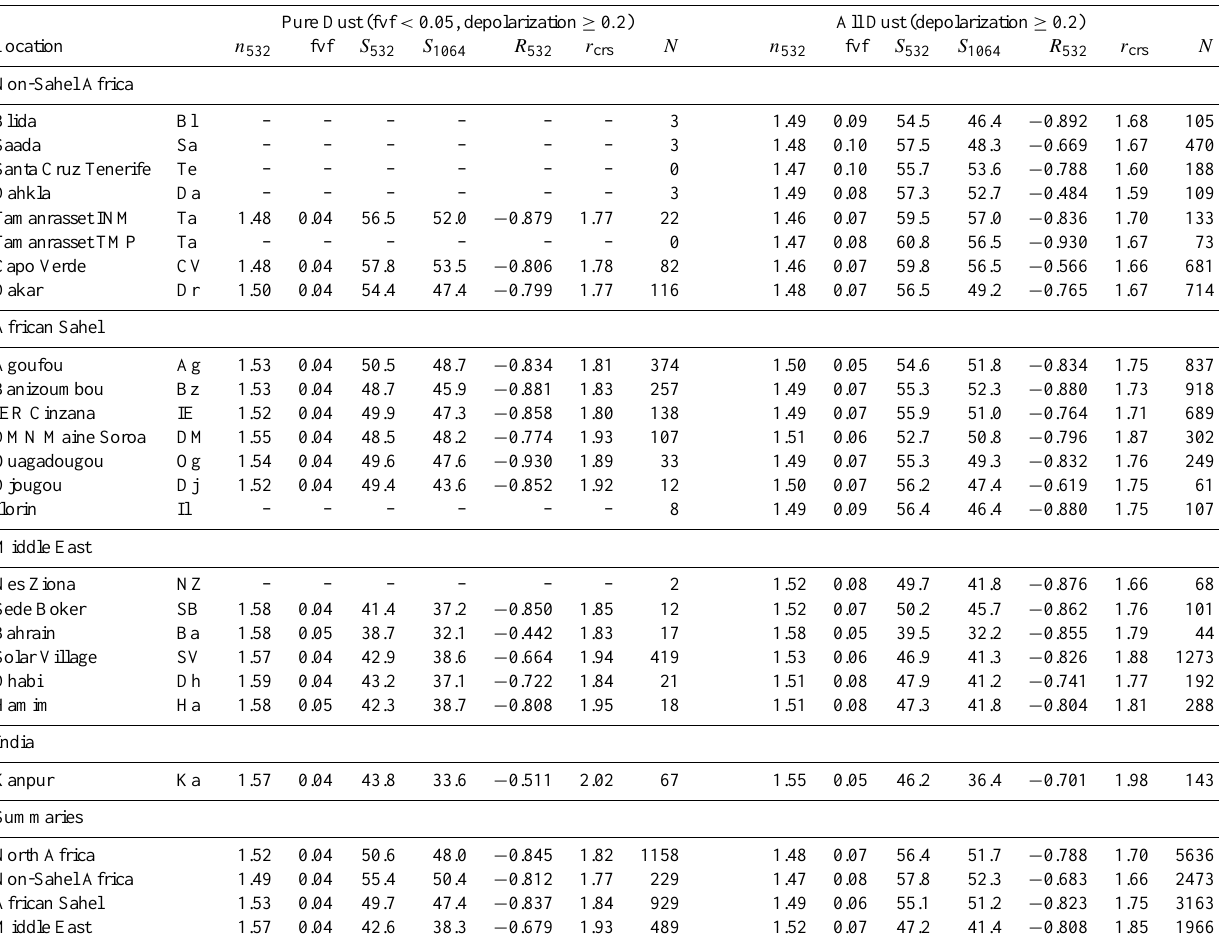
Table 4. Several parameters for “pure” dust and “all” dust at 22 AERONET sites for all data available in the months May–September with depolarization ratios greater than 0.2. n 532 denotes the median real refractive index, fvf is median fine volume fraction, S 532 and S 1064 indicate median lidar ratios (in steradians) at 0.532 and 1.064µm, R 532 is the correlation between lidar ratio and real refractive index at 0.532µm, r crs is the coarse mode effective radius, and N is the number of